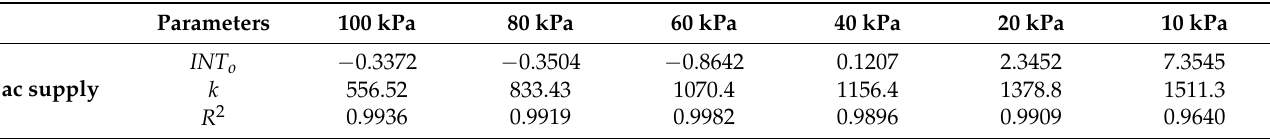
Table 1. Main parameters of the linear regression between INT normalized and E discharges 0.5 ( INT normalized = INT o + k · E discharge 0.5